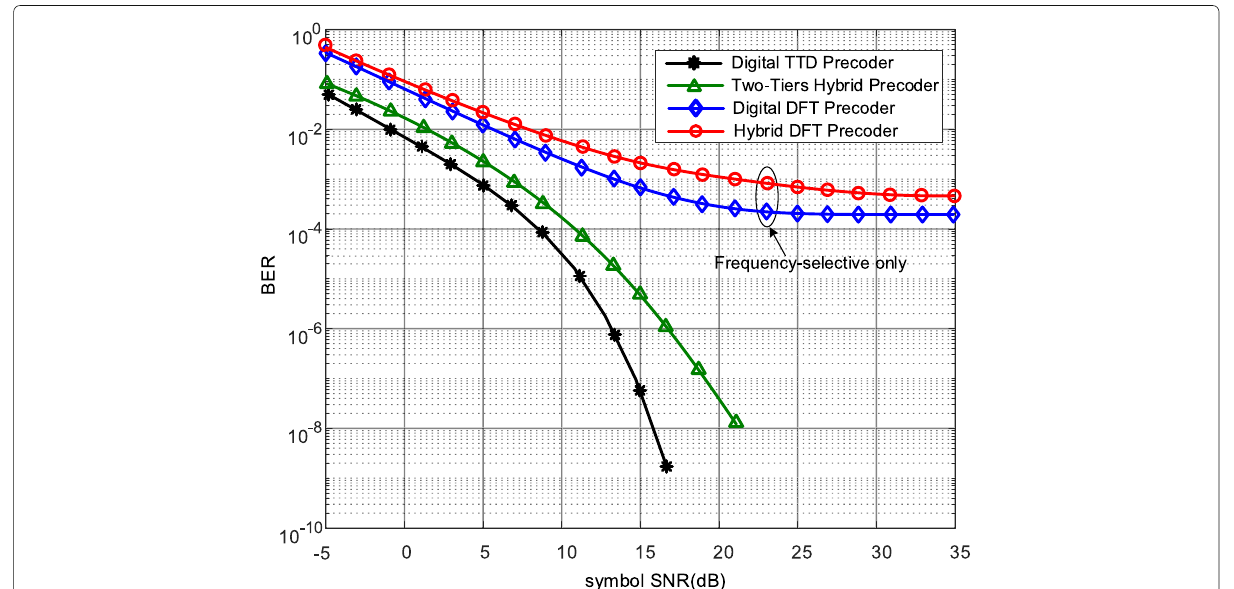
Fig. 5 BER performance comparison in single-user mmWave MIMO-OFDM systems with N t = 256, N r = 64, total bandwidth B = 1.2 GHz, = N r = N = f c = 60 GHz, N t s RF RF